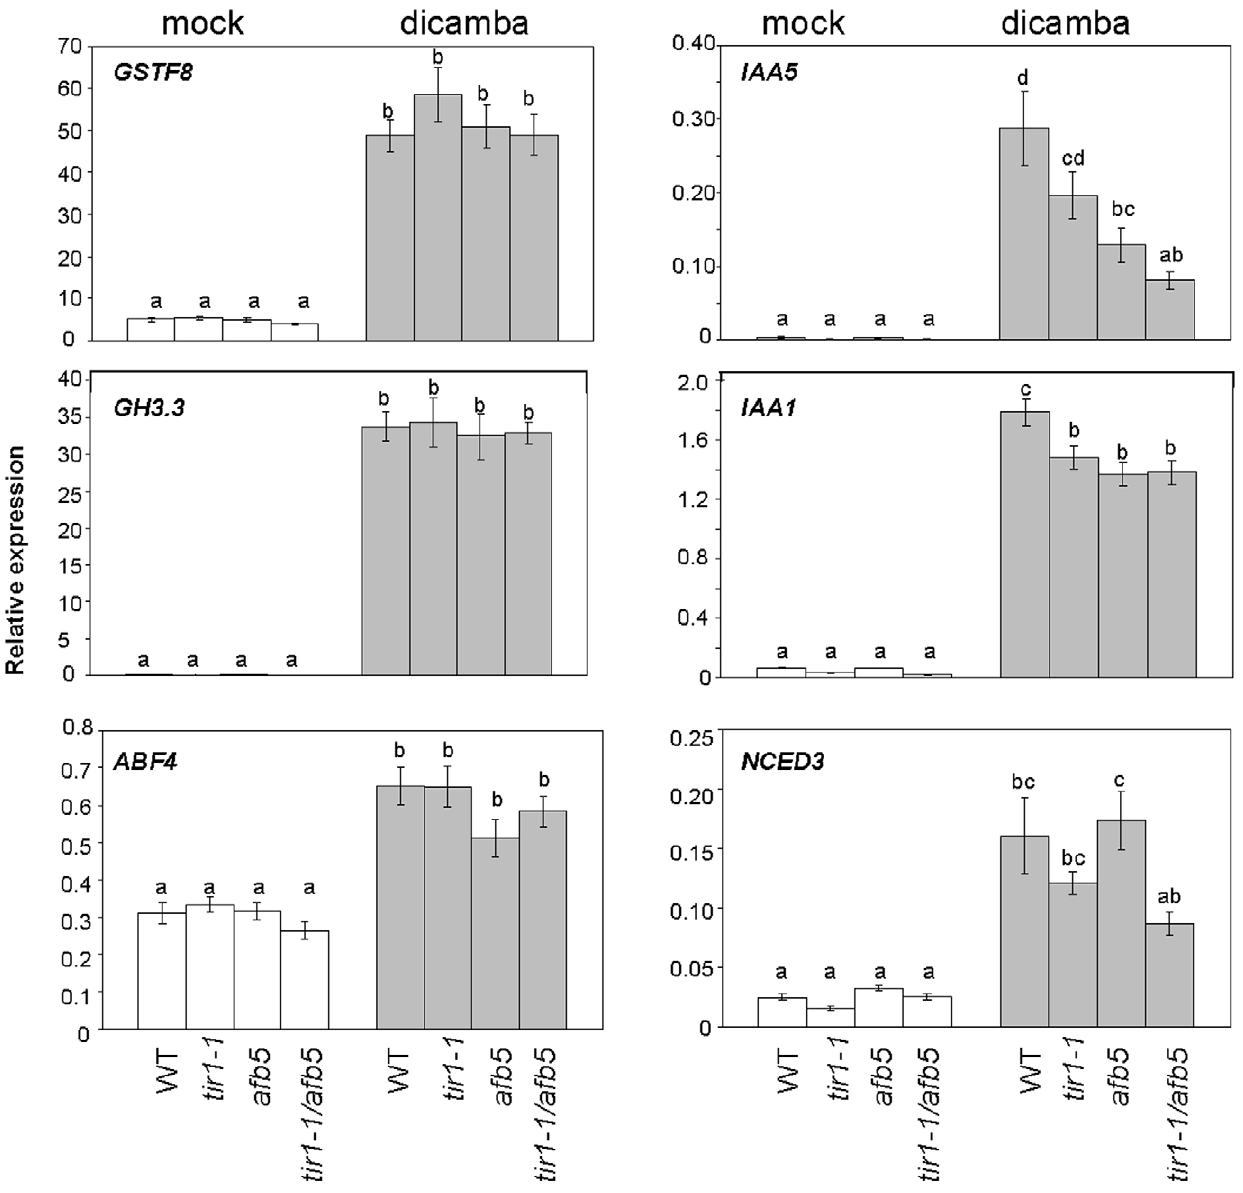
Figure 6. Consequences of tir1-1 , afb5 , and tir1-1/afb5 on the dicamba-induced expression of select genes. Transcript expression was monitored by qRT-PCR in Col-0, tir1-1 , afb5 , and tir1-1/afb5 plants after a 10 hour, 7 mM dicamba treatment. The following genes were analysed: GSTF8 (At2g47730), GH3.3 (At2g23170), ABF4 (At3g19290), IAA5 (At1g15580), IAA1 (At4g14560), and NCED3 (At3g14440). The graphs show the average relative gene expression from two independent experiments, each containing three biological replicates. (Error bars = standard error). The different letters indicate differences by Least Square Means Tukey HSD (p , 0.05). Levels not connected by the same letter are significantly different.